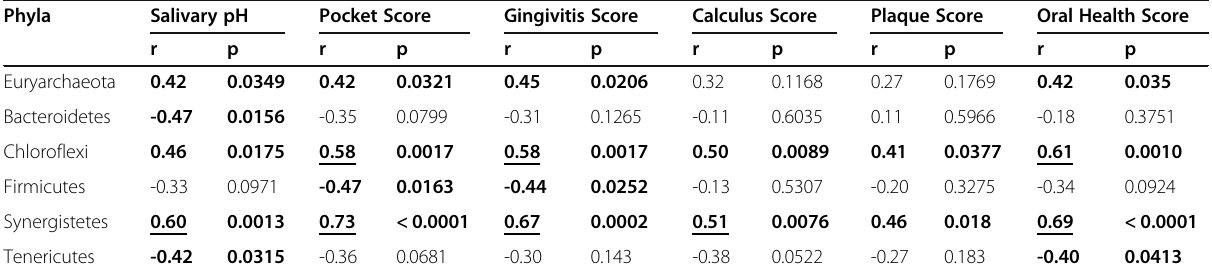
Table 6 Correlation coefficients (r) between oral health scores, plaque scores, calculus scores, gingivitis scores, pocket scores, pH, and bacterial phyla in saliva samples ( n = 26) 1 Phyla Salivary